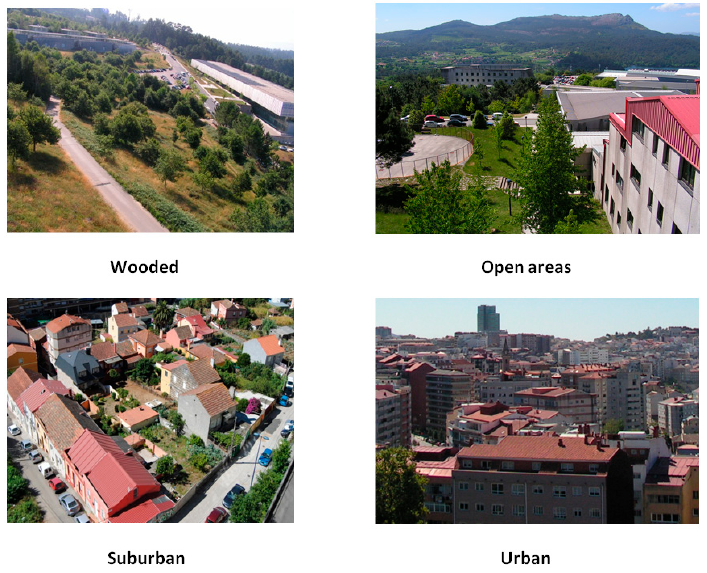
Figure 2. Measurement scenarios.